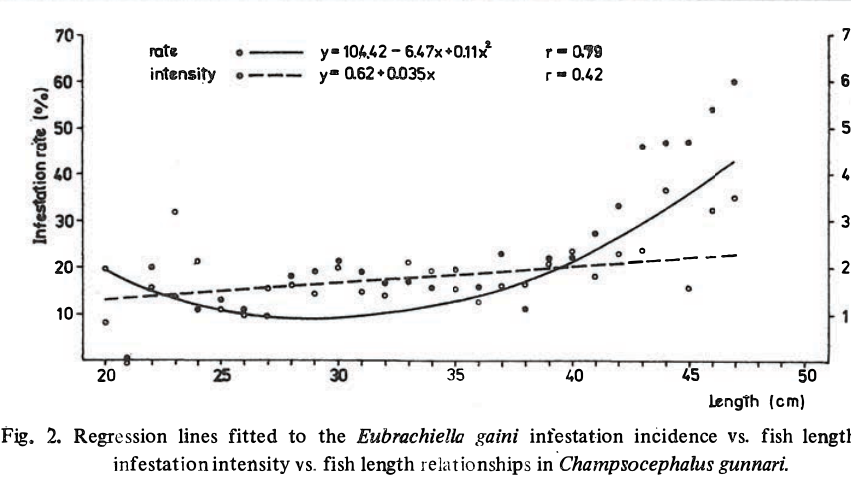
Fig. 2. Regression lines fitted to the Eubrachiella gaini infestation incidence vs. fish length and infestation intensity vs. fish length relationships in.Champsocephalus